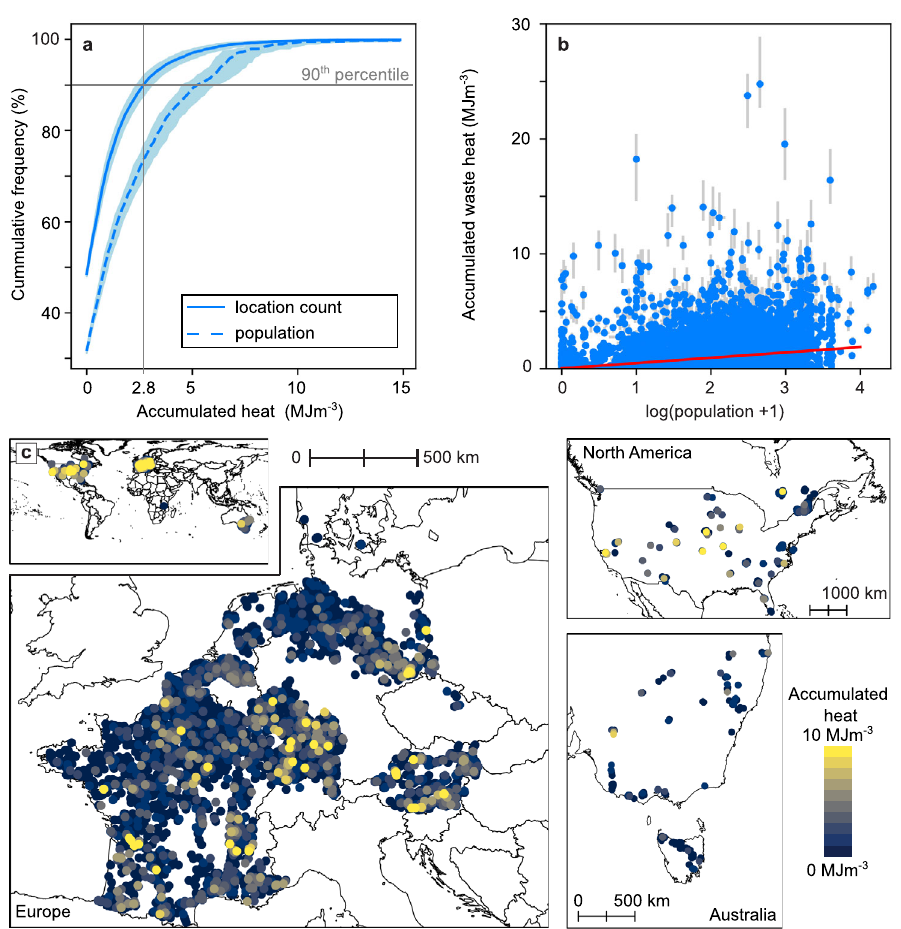
Fig. 2 Accumulated heat for the status quo . a Cumulative distribution of the heat accumulated per cubic meter at our 8118 study sites. The blue line indicates the median values, while our maximum and minimum estimates are colored in light blue. b The accumulated heat increases with population density. The red linear fi t projects an increase of 0.46 MJ m − 3 per tenfold increase in population. Error bars depict our maximum and minimum estimates. c Maps displaying the accumulated heat. A zoomable version of this map is accessible under https://susanneabenz.users.earthengine.app/view/feasible-